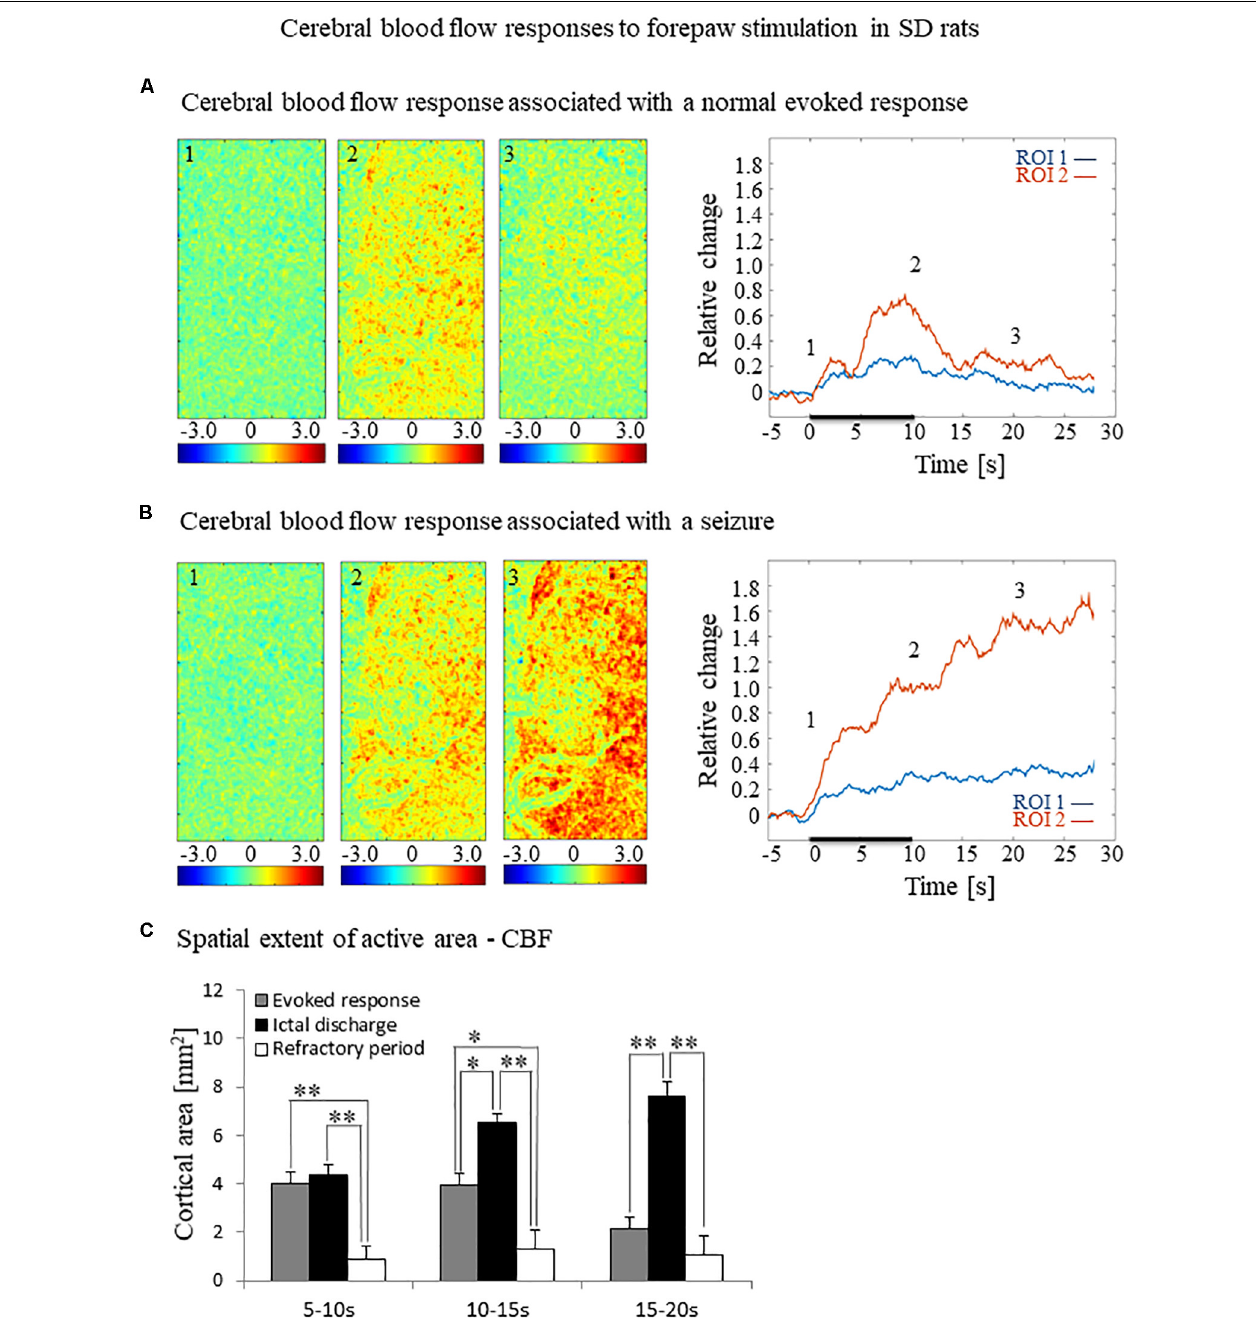
FIGURE 3 | Cerebral blood flow responses evoked by forepaw stimulation. (A) Cerebral blood flow response evoked by stimulation of the contralateral forepaw. To the left, the spatial responses before (the 1 s before stimulus onset), during (9–10 s following stimulus onset), and after (9–10 s following the cessation of the stimulus) the 10 s-long forepaw stimulation period. The reference for obtaining these responses was imaged between 3 and 1 seconds before stimulus onset. Note that positive responses indicated in indexed yellow and red colors represent increases in blood flow. To the right are two time-courses presenting the corresponding temporal responses from two regions (blue and red ROIs in Figure 2C ) within the activated area. The stimulation period between 0 and 10 seconds is marked by a dark bar. (B) Maps of the blood flow changes during a response that evoked a seizure, from before, during, and after the 10 s-long forepaw stimulation period (exact time periods are as in A). To the right are two time-courses presenting the corresponding temporal responses from the same ROIs as described in (A) . (C) A bar graph showing the spatial extent of the CBF response calculated for the epochs of 5–10 s, 10–15 s, and 15–20 s relative to the onset of the stimulus during normal evoked responses ( n = 21), seizure responses ( n = 20) and refractory periods ( n = 14; * p < 0.05, ** p < 0.001; Tamhane’s test).